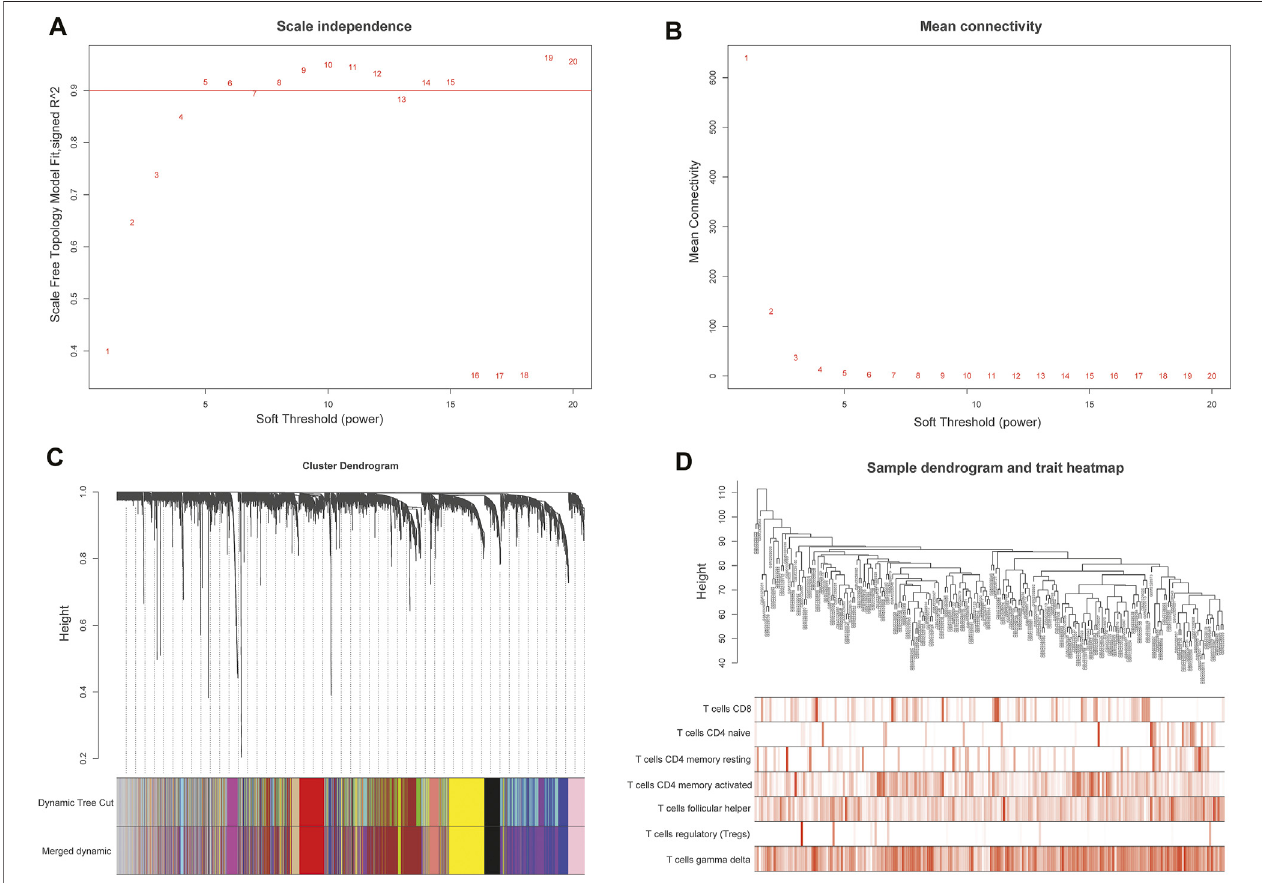
FIGURE3| Weightedgeneco-expressionnetworkanalysis(WGCNA)ofgenesinDLBCLaboutactivatedmemoryCD4 + Tcellsin fi ltration. (A) Analysisofthescale- free fi t various soft thresholding power ( β ). (B) Analysis of the average connectivity of 1 – 20 soft threshold power. (C) Hierarchical cluster tree showing co-expression modules identi fi ed by WGCNA. (D) Sample dendrogram and trait heatmap between the samples and T cells in fi ltration phenotype.